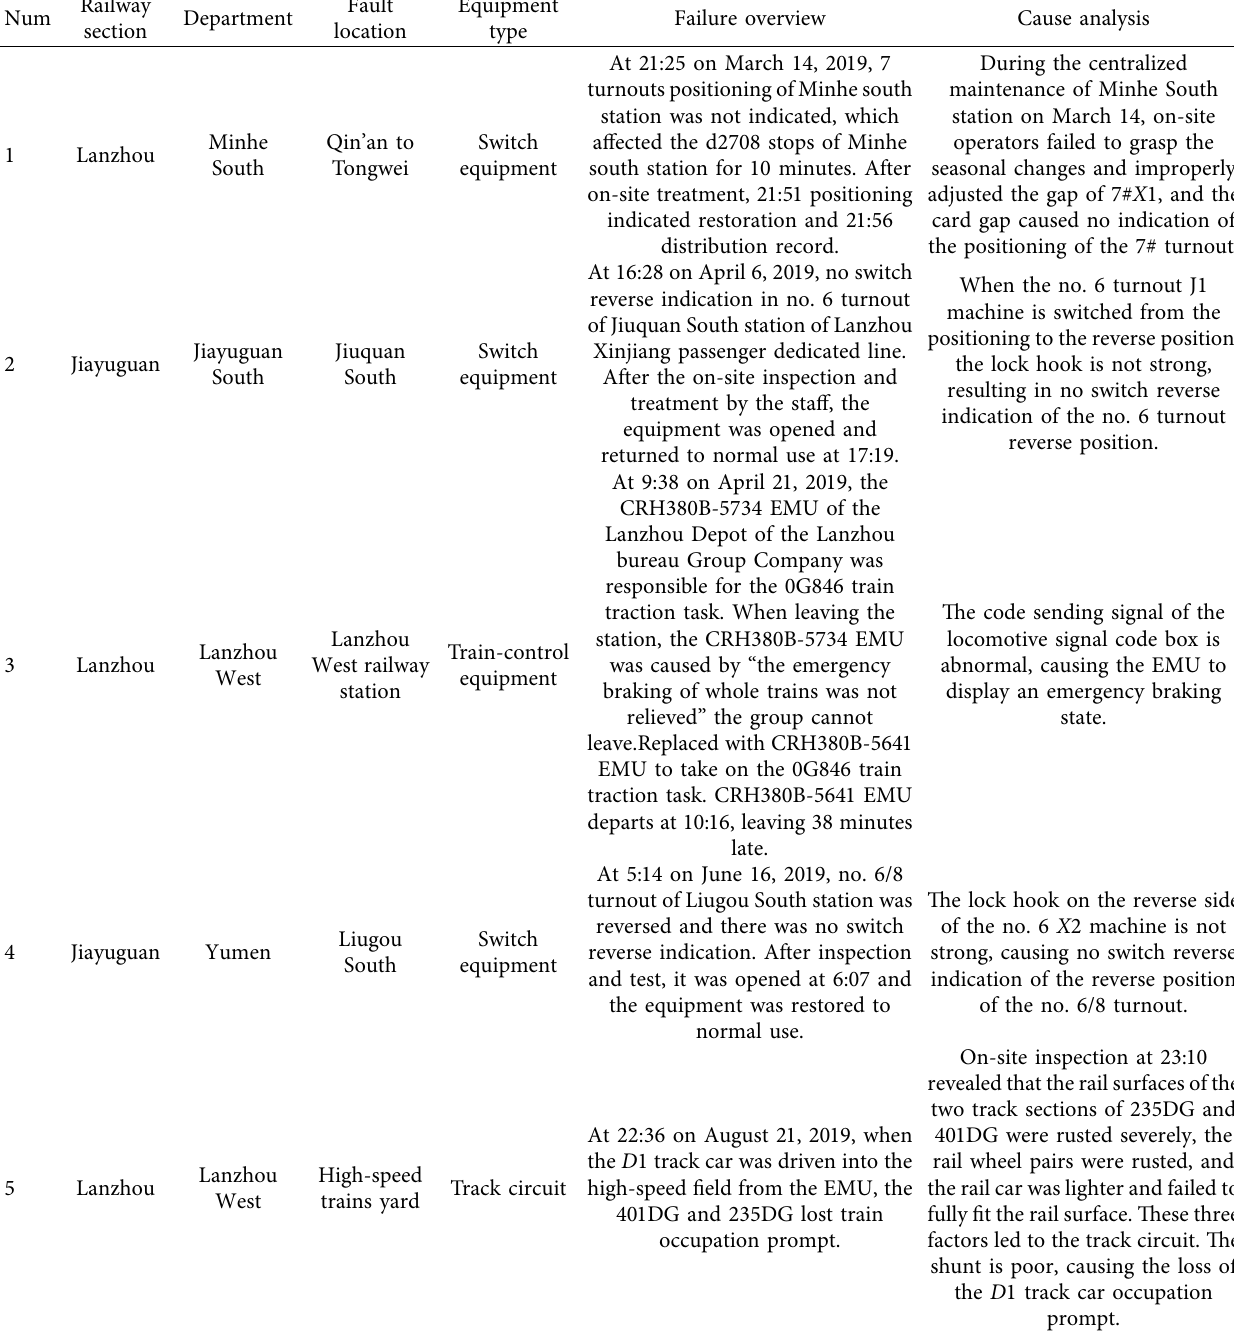
Table 1: Example of signal equipment fault